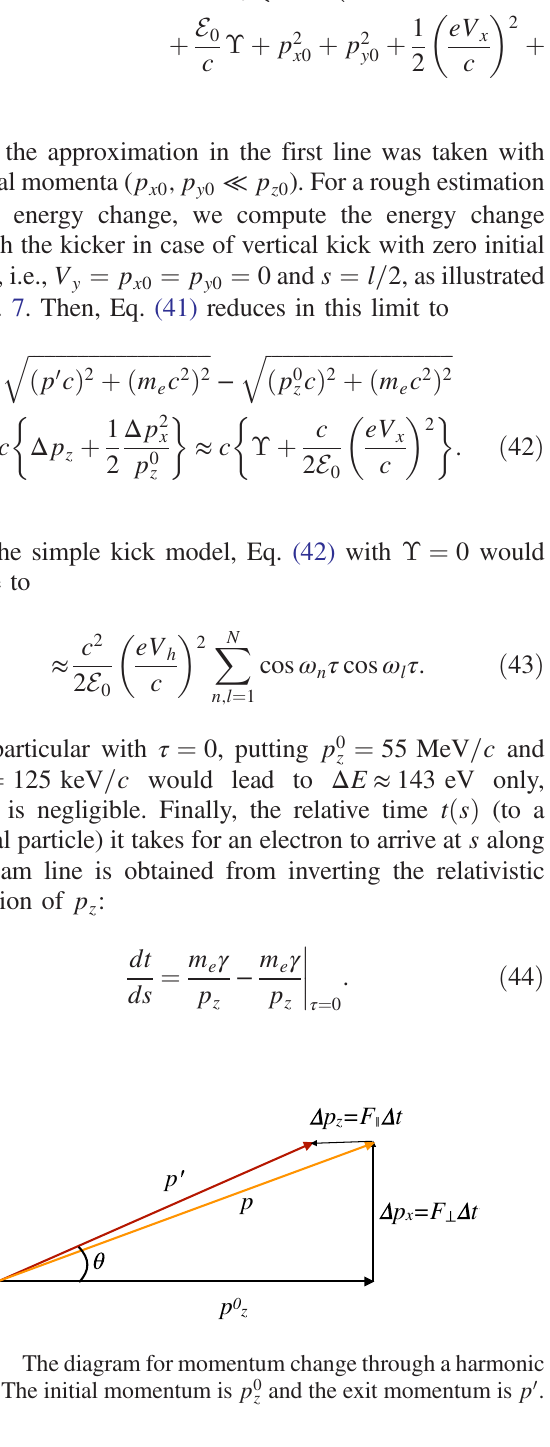
and the exit momentum is p 0 z